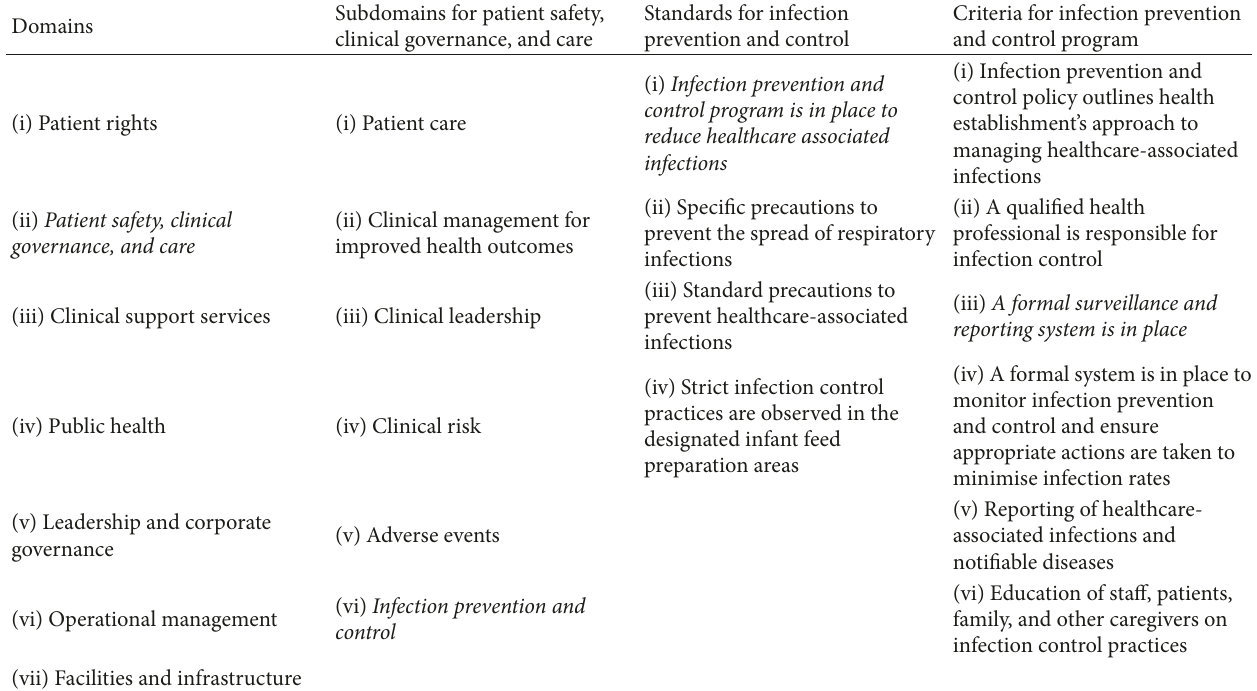
Table 1: Standards and criteria relating to prevention of healthcare-associated